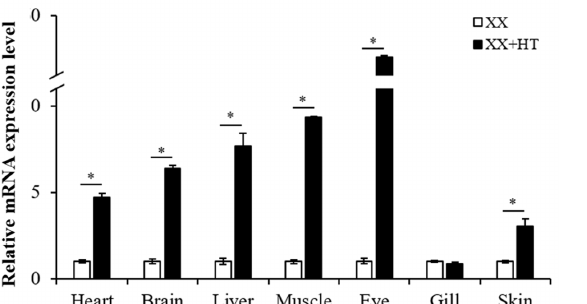
Figure 7. Expression of Jarid2b gene in various tissues as determined by qRT-PCR. XX: control female group; XX + HT: high-temperature treated female group. The expression level of Jarid2b in each tissue in the XX group was set as 1. * Statistically significant difference ( p < 0.05).